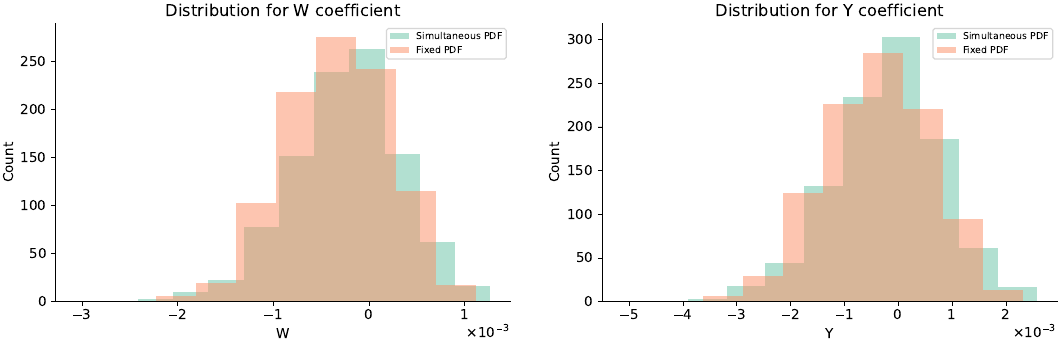
Figure 5 . Distribution of best fit W (left panel) and Y values (right panel) obtained across 1000 replicas by fitting each of the Wilson coefficients alongside PDFs with the SIMUnet methodology (green) compared to the distribution that one would obtain by keeping the PDFs fixed to the SM baseline